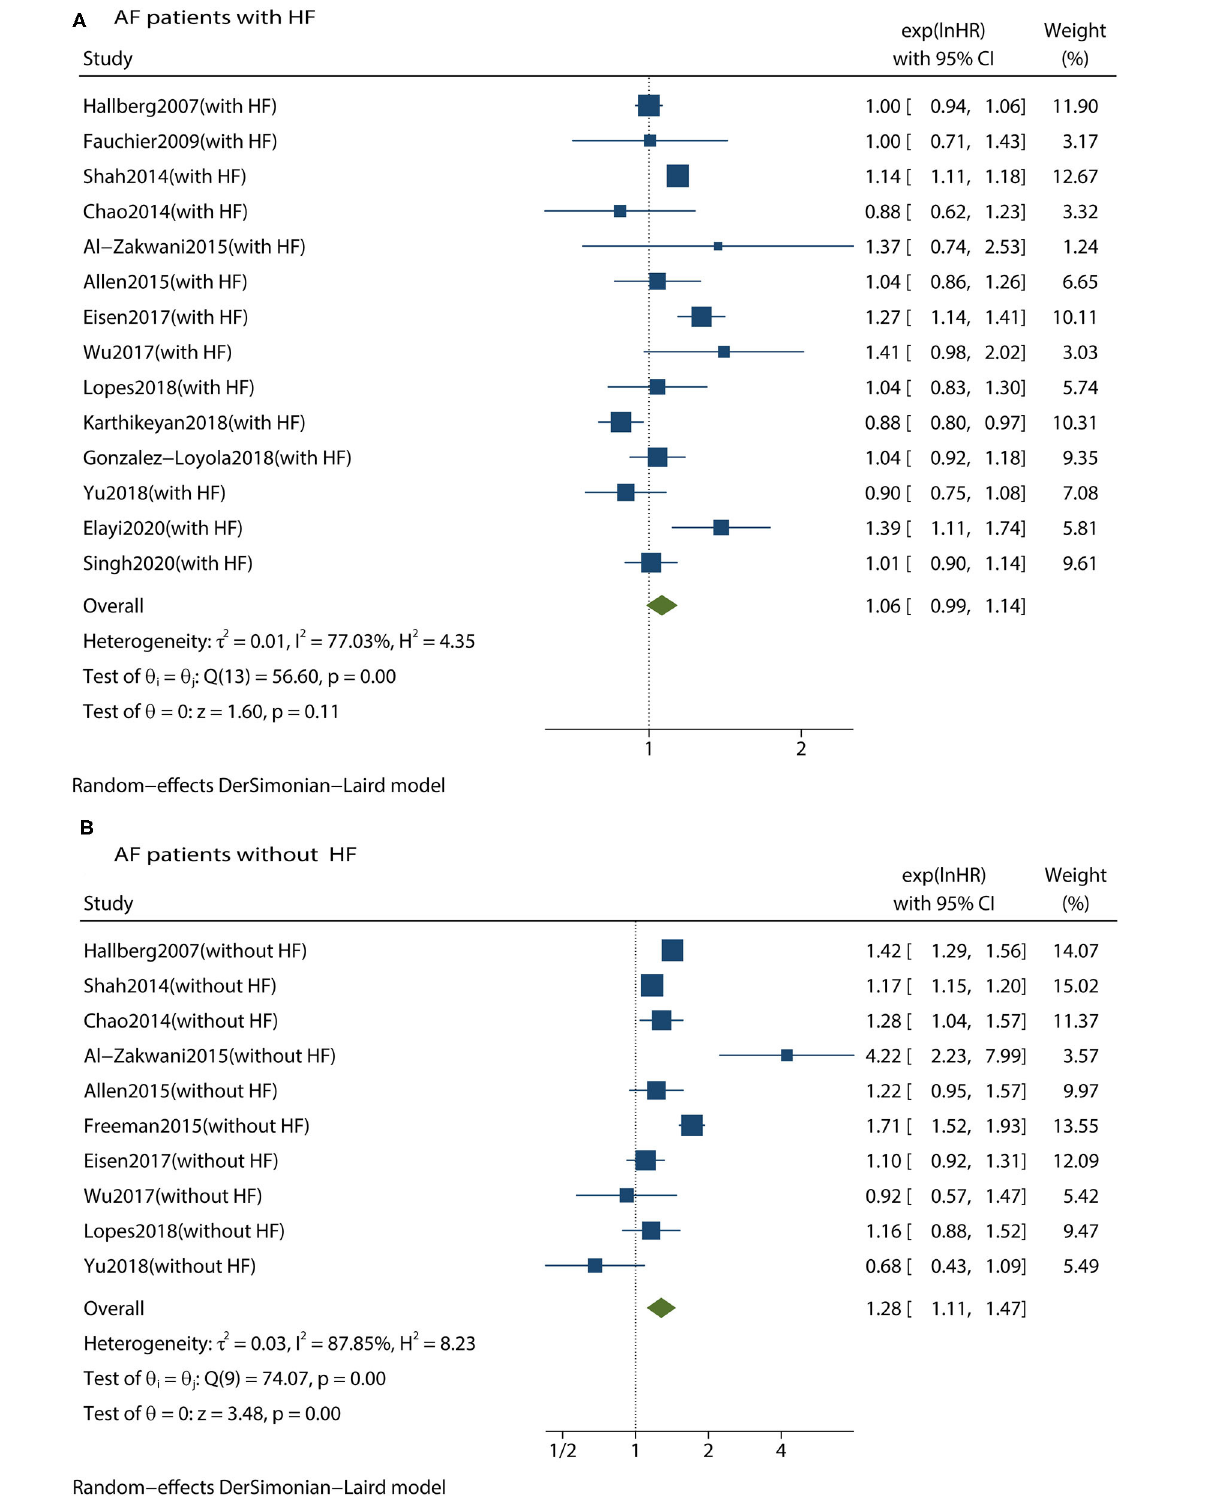
Frontiers in Cardiovascular Medicine |